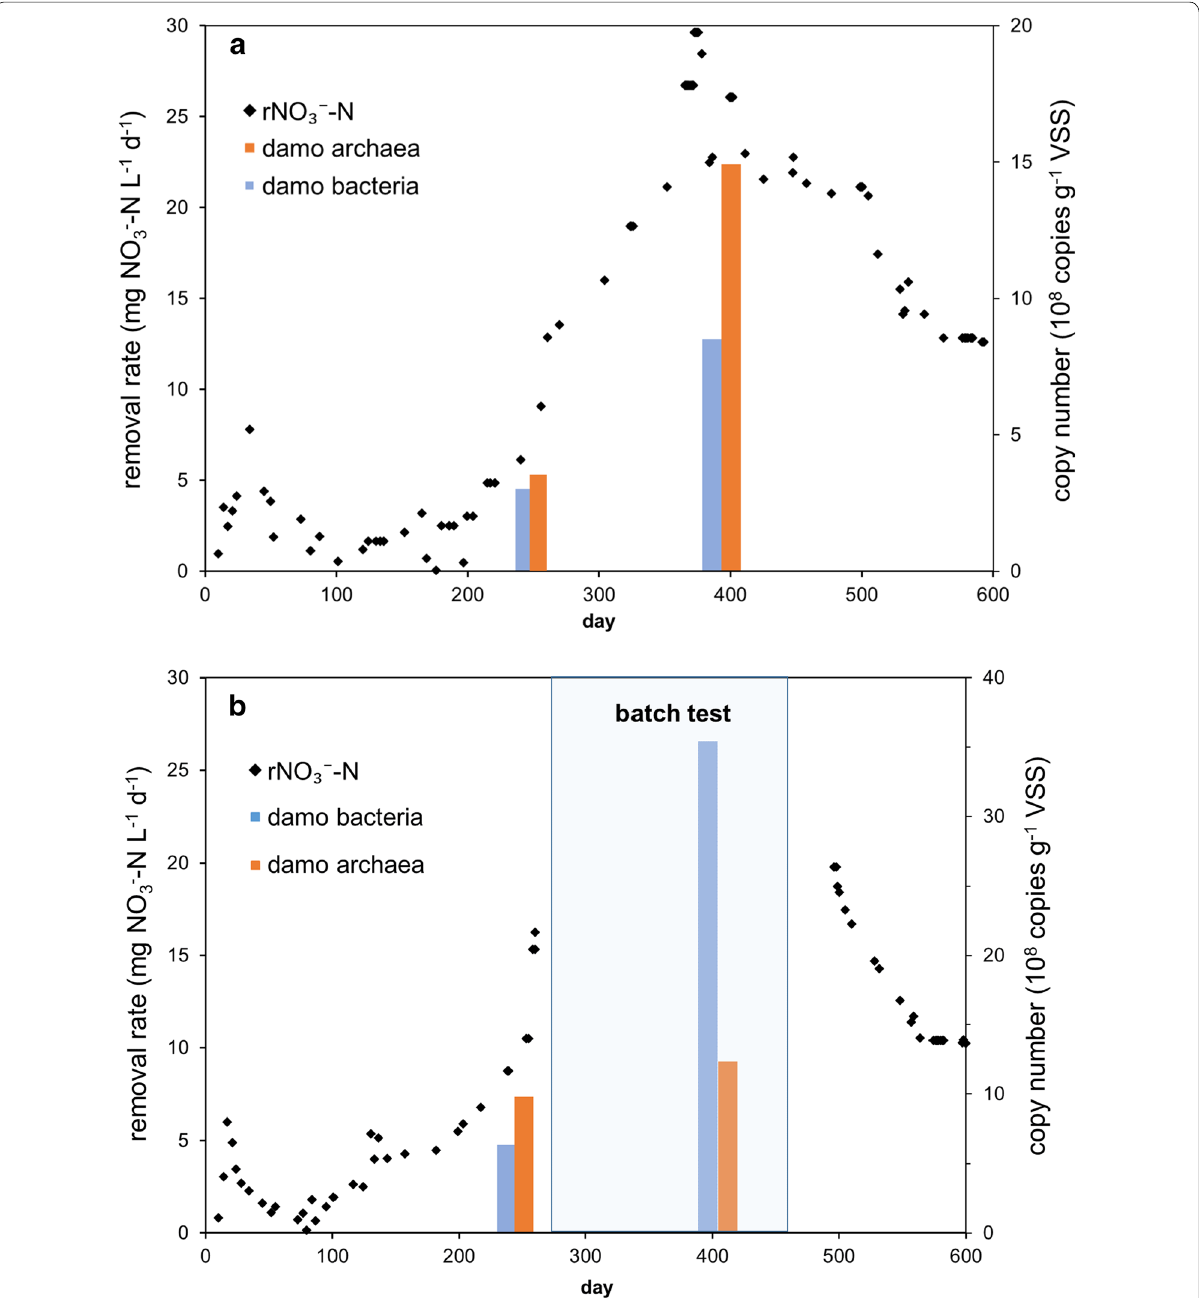
Fig. 2 Process performance of the reactors during the 600 days. a Nitrate removal rates, copy numbers of damo bacteria16S rRNA gene and damo archaea 16S rRNA gene in reactor A; b nitrate removal rates, copy numbers of damo bacteria 16S rRNA gene and damo archaea 16S rRNA gene in reactor B